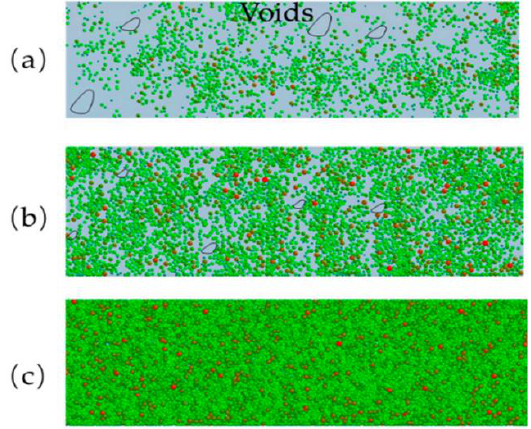
Figure 7. Powder flow velocity under different roller’s translational velocity [ 46].